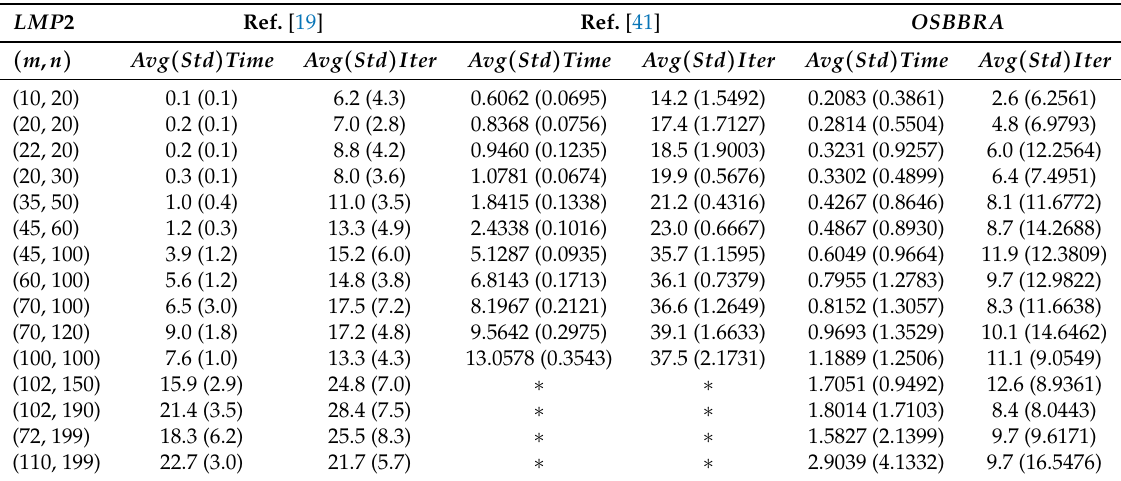
Table 6. Computational results on (LMP2) ( p = 2) and comparison with results reported in [19,41].